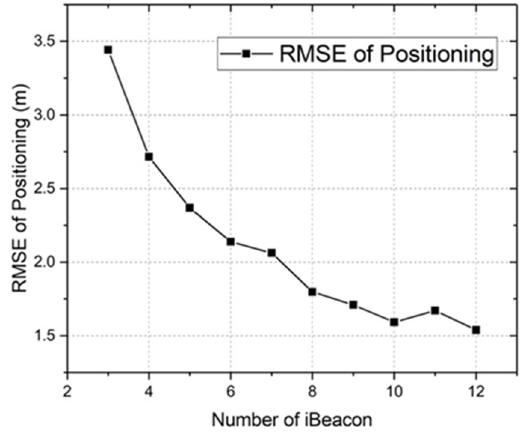
ff erent number of